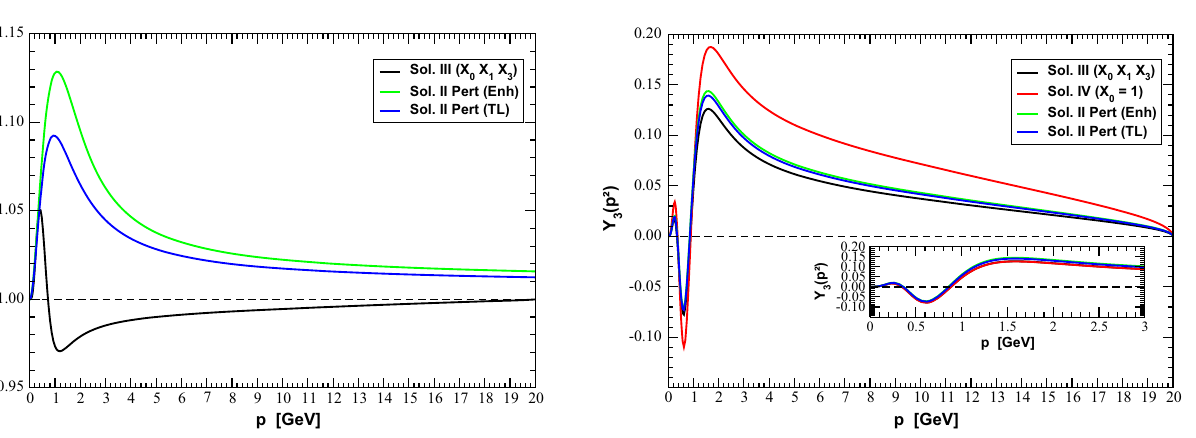
In summary, Figs. 26, 27, 28 and 29 resume the compu- tations of the quark-ghost kernel form factors performed so